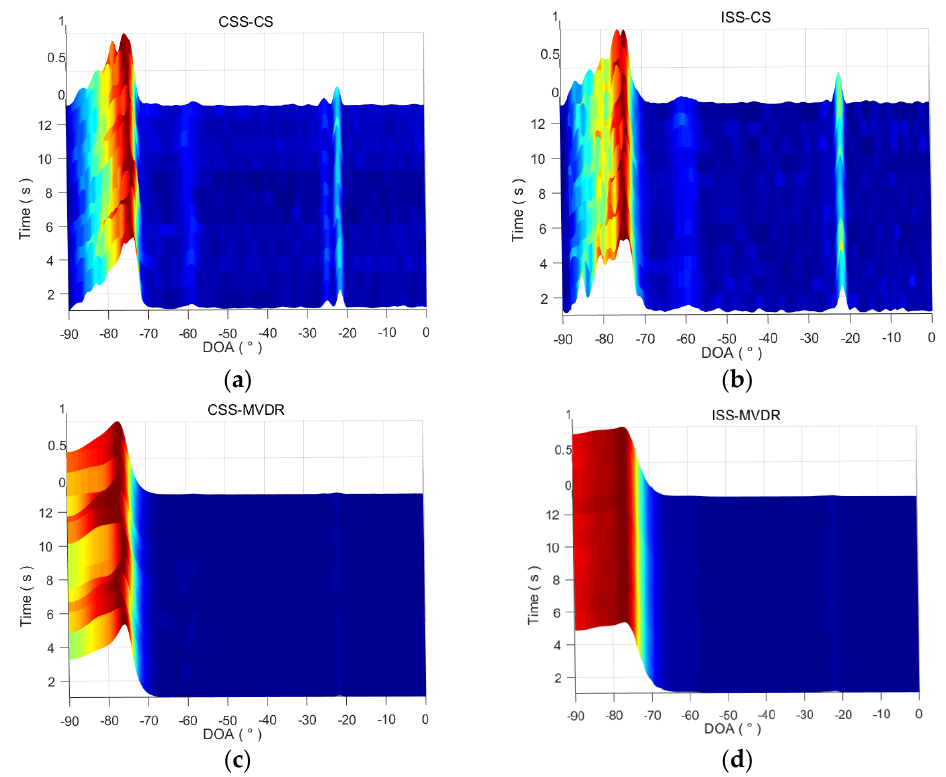
Figure 9. Three-dimensional DOA time tracks estimated by four methods. ( a ) Three-dimensional DOA time tracks estimated by CSS-CS; ( b ) Three-dimensional DOA time tracks estimated by ISS-CS; ( c ) Three-dimensional DOA time tracks estimated by CSS-MVDR; ( d ) Three-dimensional DOA time tracks estimated by ISS-MVDR.